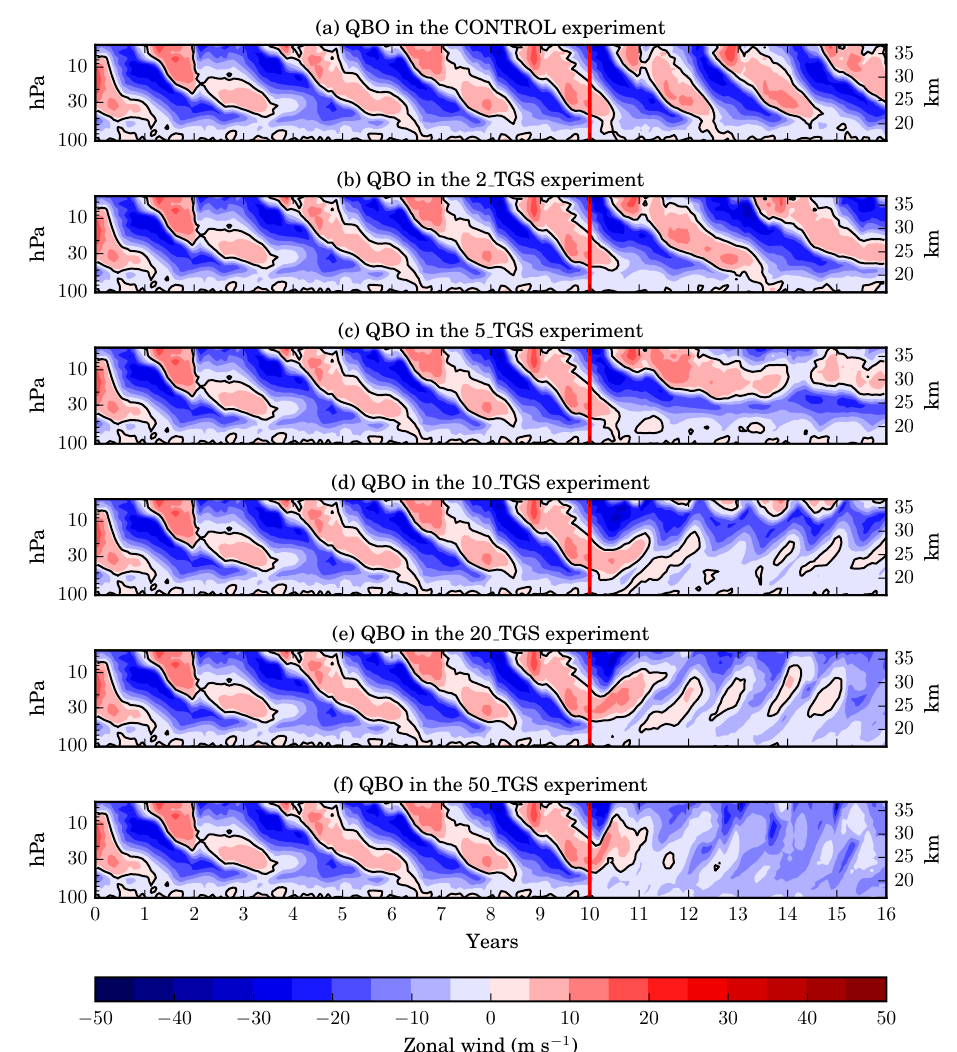
Figure 15. Temporal evolution of the vertical profiles of zonal wind averaged zonally and between 2 ◦ N and 2 ◦ S. The QBO can be seen in the alternating downward propagation of the easterly (blue) and westerly (red) wind direction. All the simulations share the same background aerosol spin-up period of 10 years. The onset of the continuous sulfur injections is marked by a red